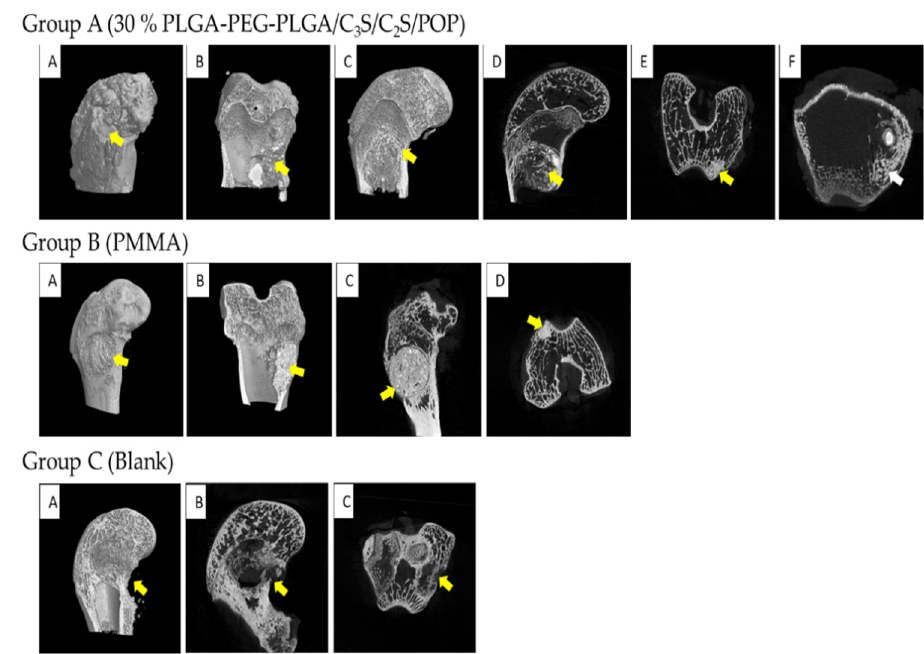
Figure 14. MICRO-CT results of femoral condyles and implant material 6 weeks after operation. Group A (30% PLGA–PEG–PLGA/C3S/C2S/POP): ( A – C ) three-dimensional reconstruction; ( D – F ) sagittal, coronal, and horizontal, respectively. The yellow arrow pointed to the composite bone cement filler material and the white arrow pointed to the new bone trabecula. Group B (PMMA): ( A , B ) reconstructed in three dimensions; ( C , D ) sagittal and coronal, respectively. The yellow arrow refers to PMMA bone cement filling material, which had a clear boundary with the surrounding bone, and no obvious new bone trabecula was found. Group C (Blank): ( A ) three-dimensional reconstruction map, ( B ) sagittal plane, and ( C ) coronal plane. Yellow arrow pointed to the defect of the femoral condyle, and no healing was observed.